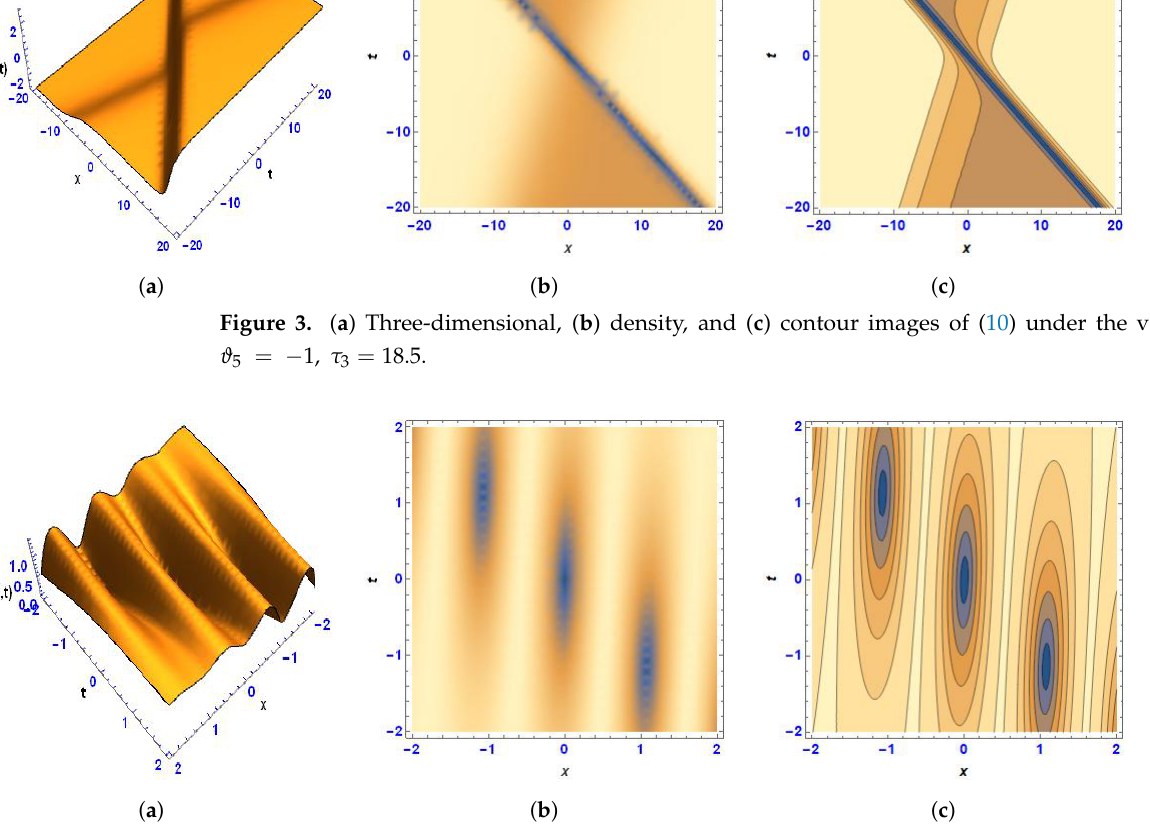
Figure 4. ( a ) Three-dimensional, ( b ) density, and ( c ) contour images of (11) under the values ϑ 3 = 3.14, τ 2 =